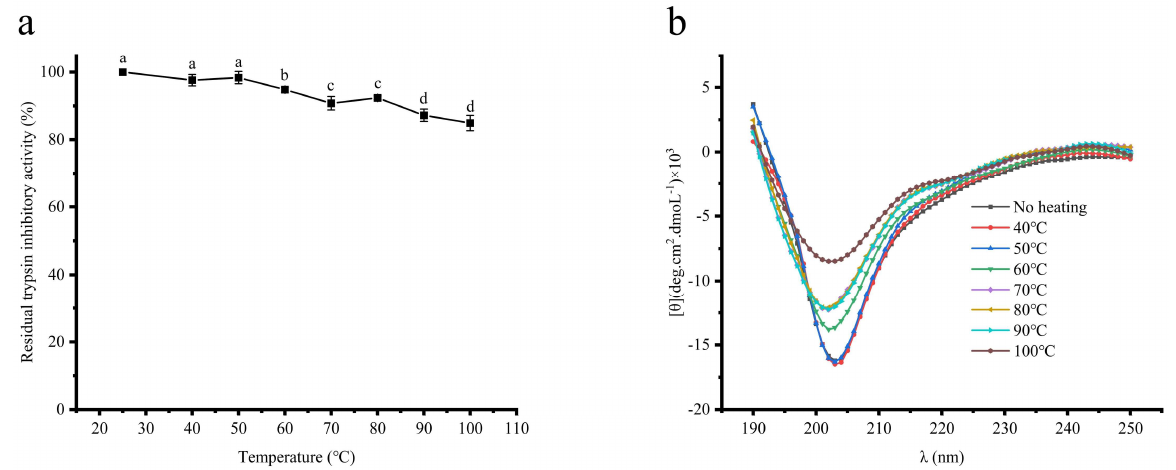
Figure 6. The effect of temperature on the activity of STI ( a ). The circular dichroism spectra of STI ( b ). Different letters indicate significant differences ( p < 0.05) among the different conditions. Residual trypsin inhibitory activity is expressed as the percentage of trypsin inhibitory activity after the treatment accounting for trypsin inhibitory activity of the untreated STI (25 °C).